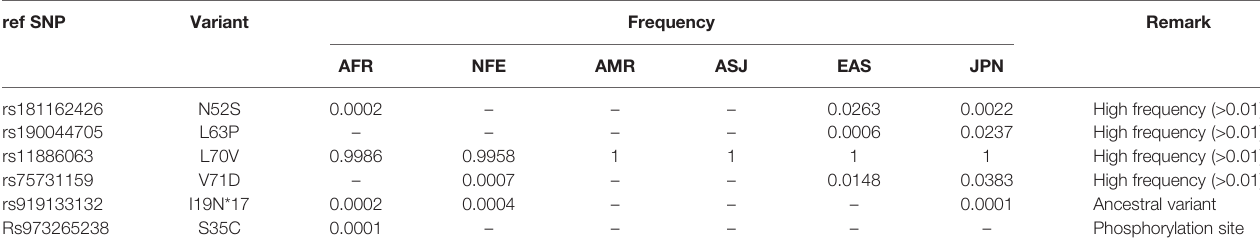
TABLE 2 | Frequency of NCYM SNPs.